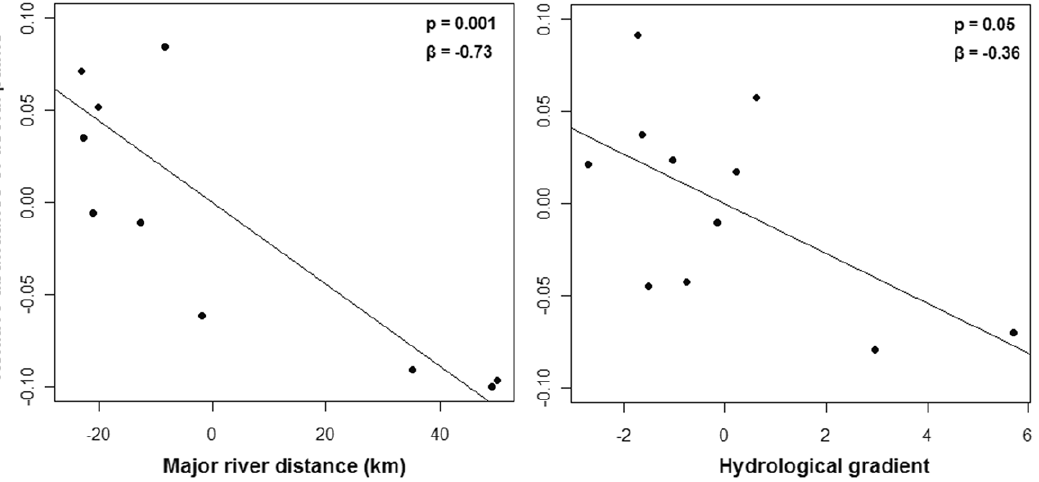
Figure 5. Multiple regression analysis of useful palms and the distance from rivers and the hydrologic gradient. Partial regressions between the relative abundance of useful palms and the distance of each plot to the major rivers (left) and the hydrologic gradient (right). The full multiple regression model has an R 2 =0.73. Points are the plots of all sites, totaling 11 plots.